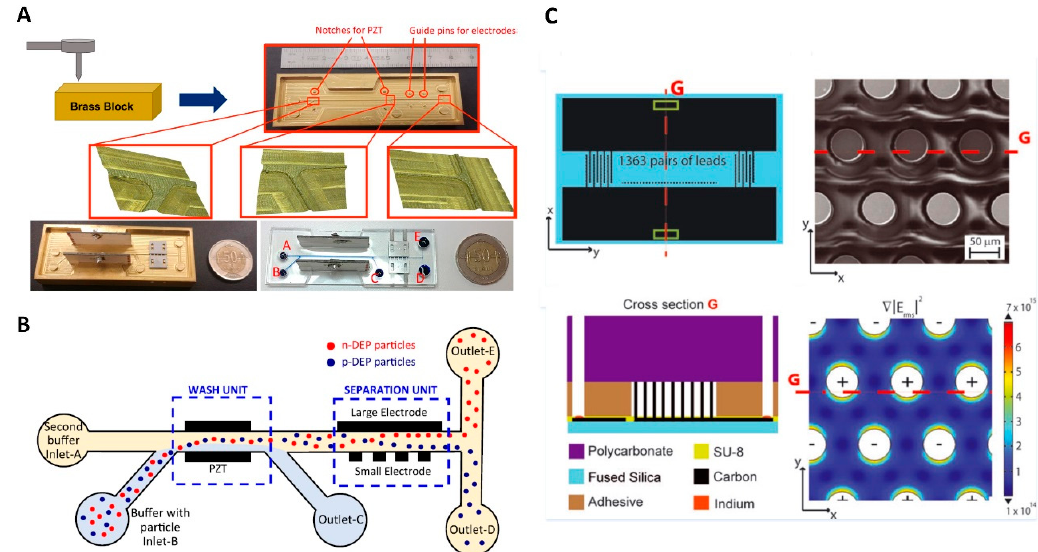
Figure 11. Devices with 3D electrodes. ( A ) Photograph of the device combined with piezoelectric ceramic transducer slides made of lead-zirconate-titanate (PZT) slides and metal electrodes. ( B ) Principle of the device. The PZT slides were used to focus the particles, and the particles were separated in the following NUEF area. Reproduced with permission from [80], © 2016 American Institute of Physics (AIP) Publishing. ( C ) Schematic and simulation of the device with a carbon electrode array. Reproduced with permission from [81], © 2013 John Wiley and Sons.